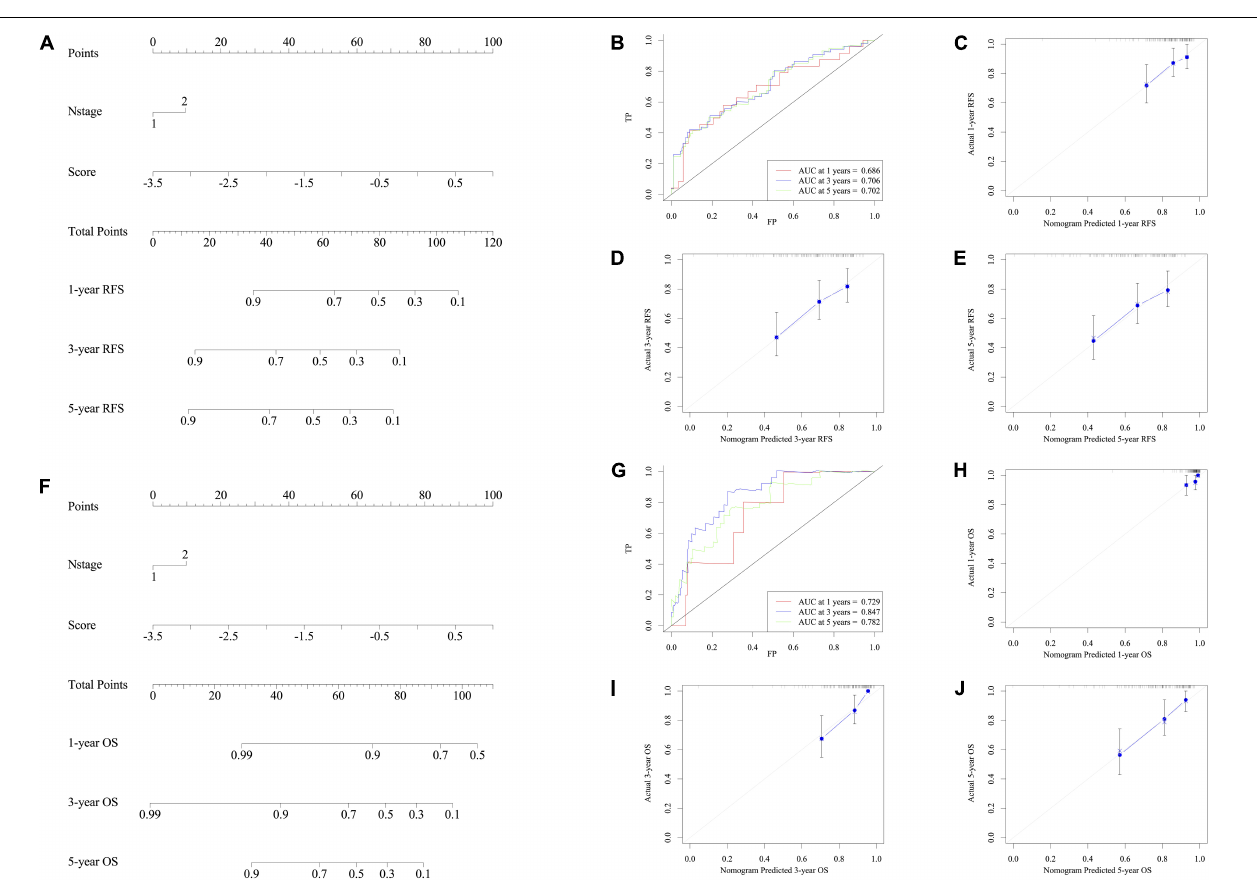
FIGURE 7 | Nomograms convey the results of prognostic models using the seven-HCL-related signature and pathology N stage to predict RFS of patients with CRC in TCGA cohort. The AUC at 1-year prediction was 0.686 (A,B) . The x -axis is nomogram-predicted probability of survival and y -axis is actual survival. The reference line is 45 ◦ and indicates perfect calibration ( C as 1-year, D as 3-year, and E as 5-year). Nomograms convey the results of prognostic models using the seven-HCL-related signature and pathology N stage to predict OS of patients with CRC in TCGA cohort. The AUC at 1-year prediction was 0.729 (F,G) . The x -axis is nomogram-predicted probability of survival and y -axis is actual survival. The reference line is 45 ◦ and indicates perfect calibration ( H as 1-year, I as 3-year, and J as 5-year).